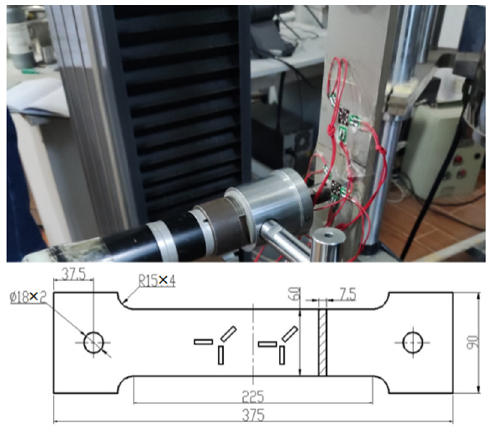
Figure 4. Calibration samples of calibration coefficients A and B.